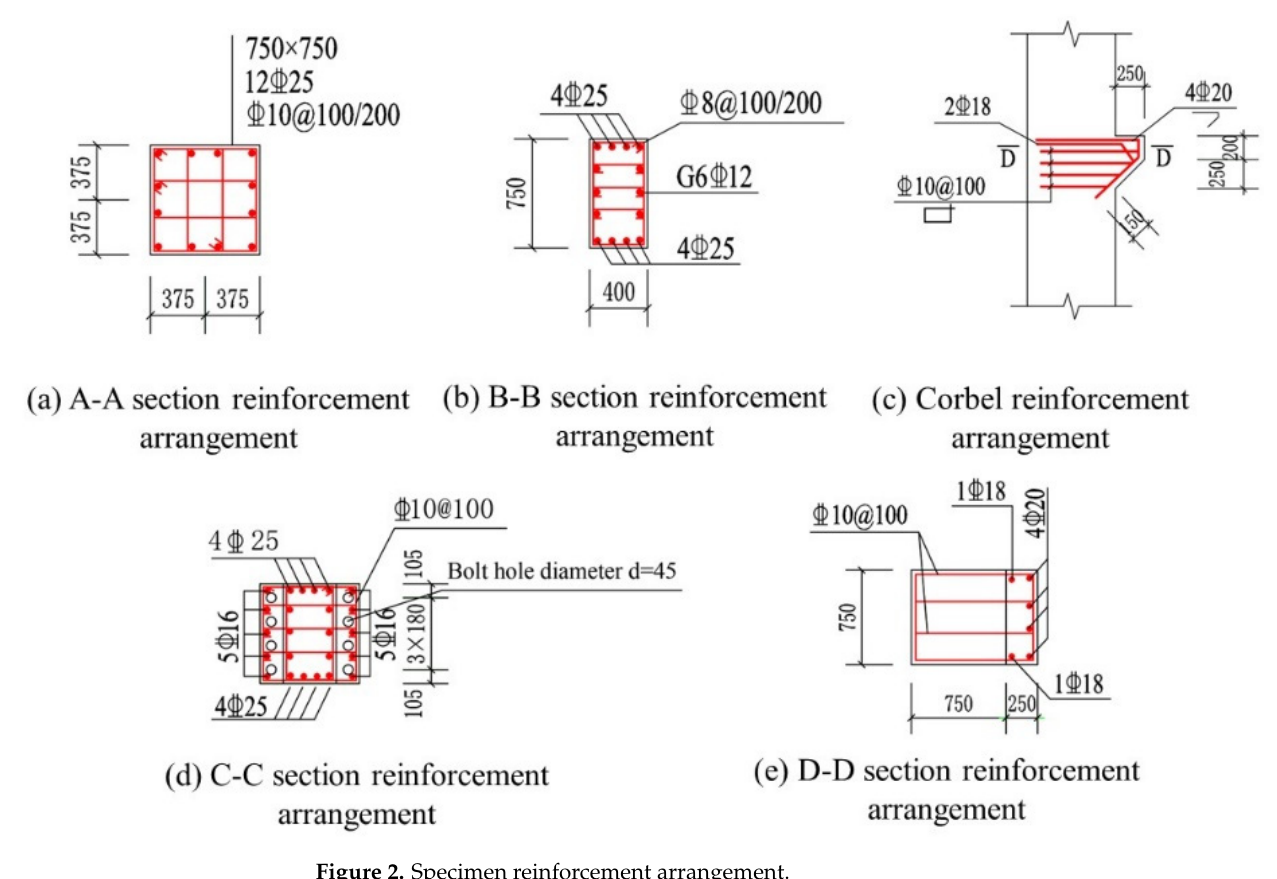
Figure 2. Specimen reinforcement arrangement.